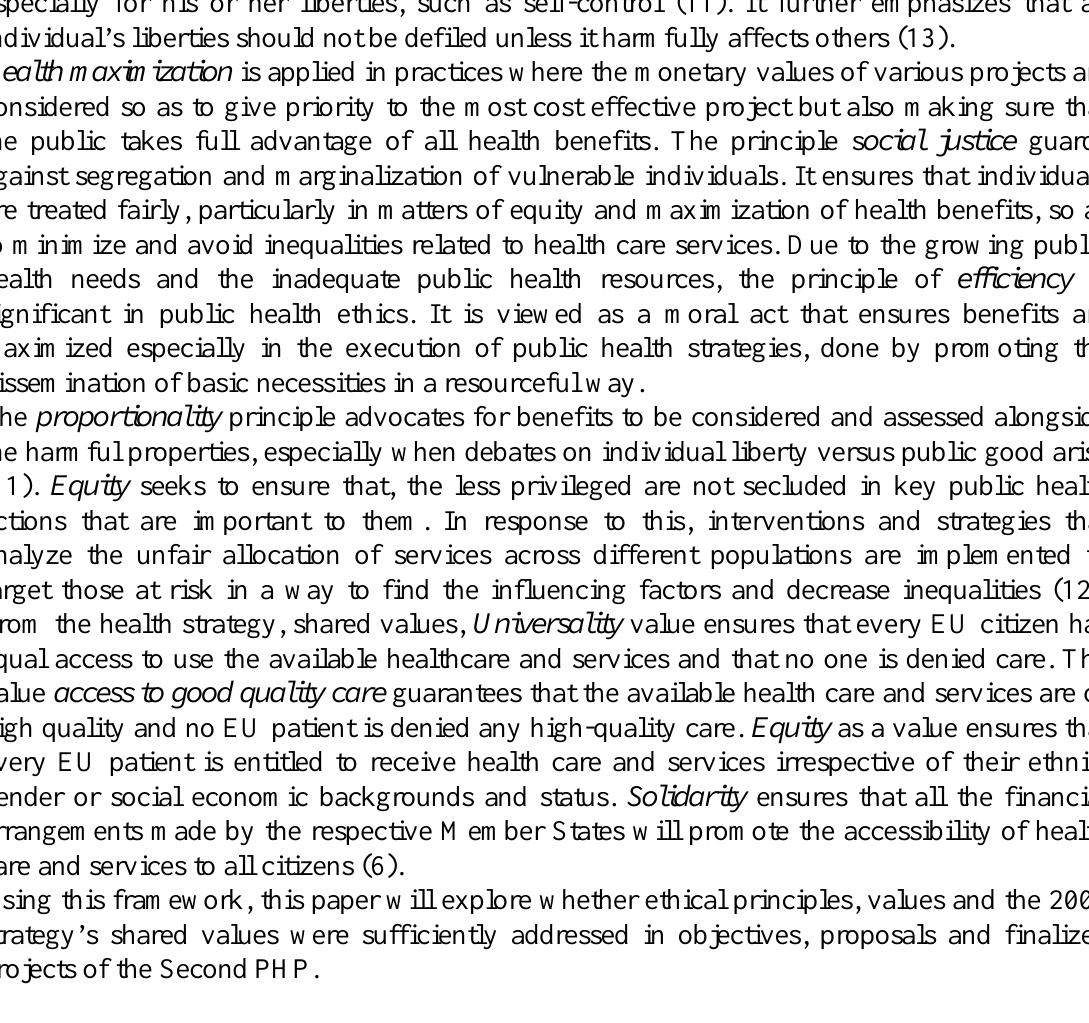
Table 1. Overview of ethical principles and health strategy